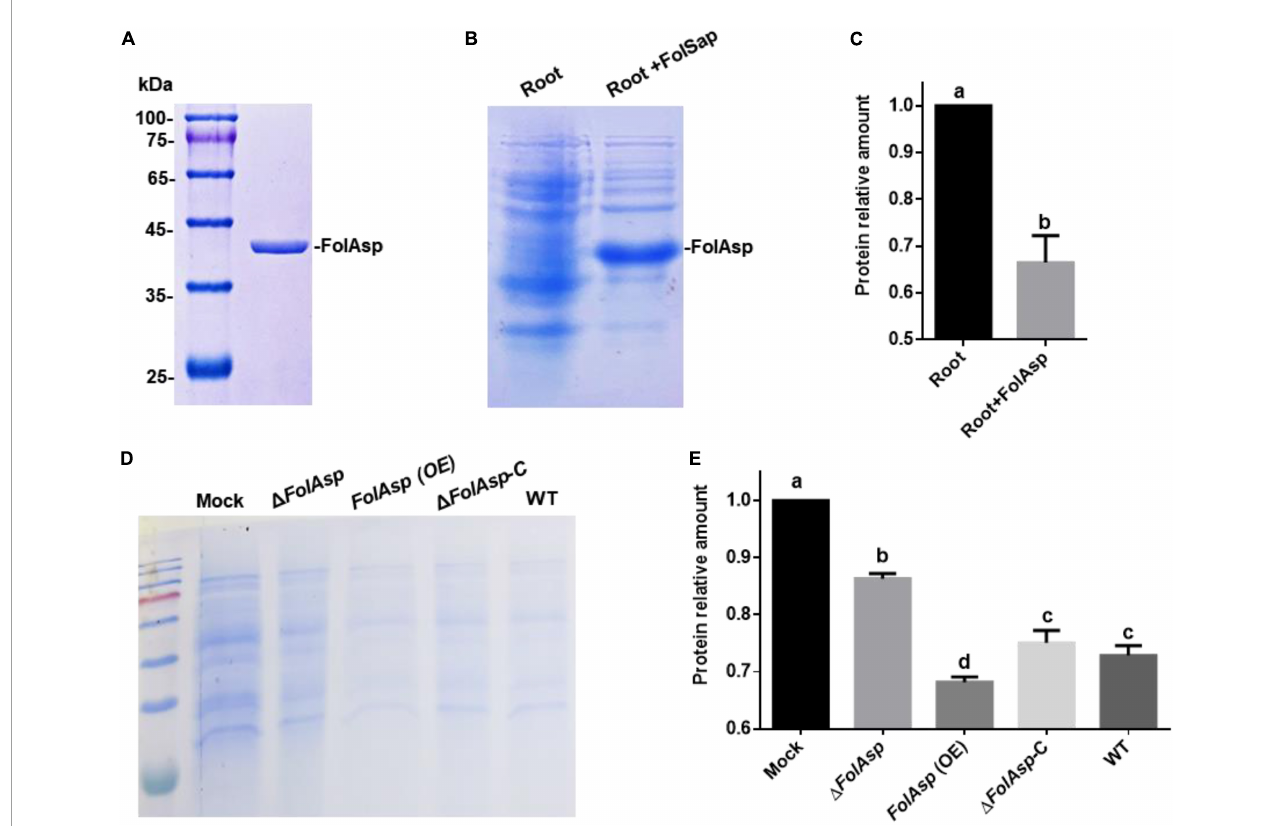
FIGURE7 FolAsp possesses protease activity on host protein. (A) CBB-stained SDS-PAGE gel of purified FolAsp-his protein is shown. Heterologous expression of recombinant FolAsp-his protein using Escherichia coli BL21. Extracted protein was incubated with Ni-NTA agarose and then eluted with imidazole. (B) FolSap promoted degradation of host protein. The extracted root protein was inoculated with 1 µ g purified FolSap for 2 h. CBB-stained SDS-PAGE gel of supernatant fractions is shown. (C) Quantification of the relative root protein abundance after FolAsp treatment, as in (B) . (D) Amount of tomato protein following treatment with the indicated strains or without any treatment as the control (Mock). The root protein was extracted and incubated with the spores of the indicated strains for 4 h. CBB-stained SDS-PAGE gel of supernatant fractions is shown. (E) Quantification of root proteins treated with Fol strains relative to Mock, as in (D) . For (C,E) , statistical significance was revealed by one-way ANOVA (mean ± SE of 3 independent biological replicates, p <